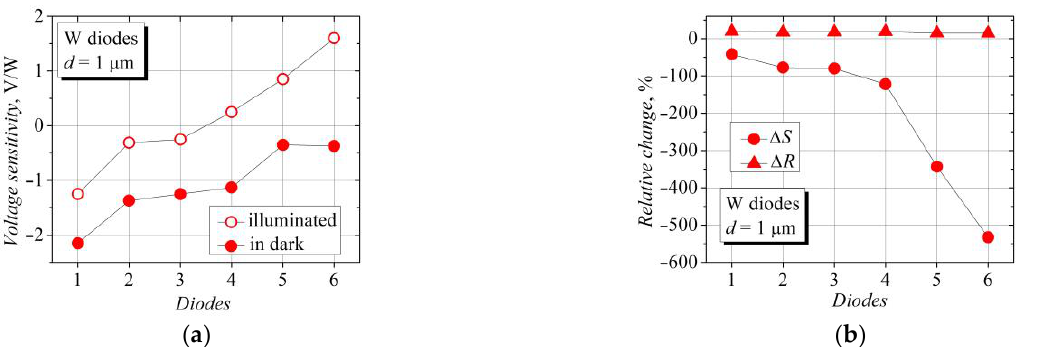
Figure 4. ( a ) Statistical representation of voltage sensitivity of six bow‑tie diodes on the bases of W structures under illumination (open dots, illuminance 14,400 lx.) and in the dark (solid dots); ( b ) statistical representation of illumination‑induced relative change in voltage sensitivity ∆ S and electrical resistance ∆ R of the same W‑diodes.